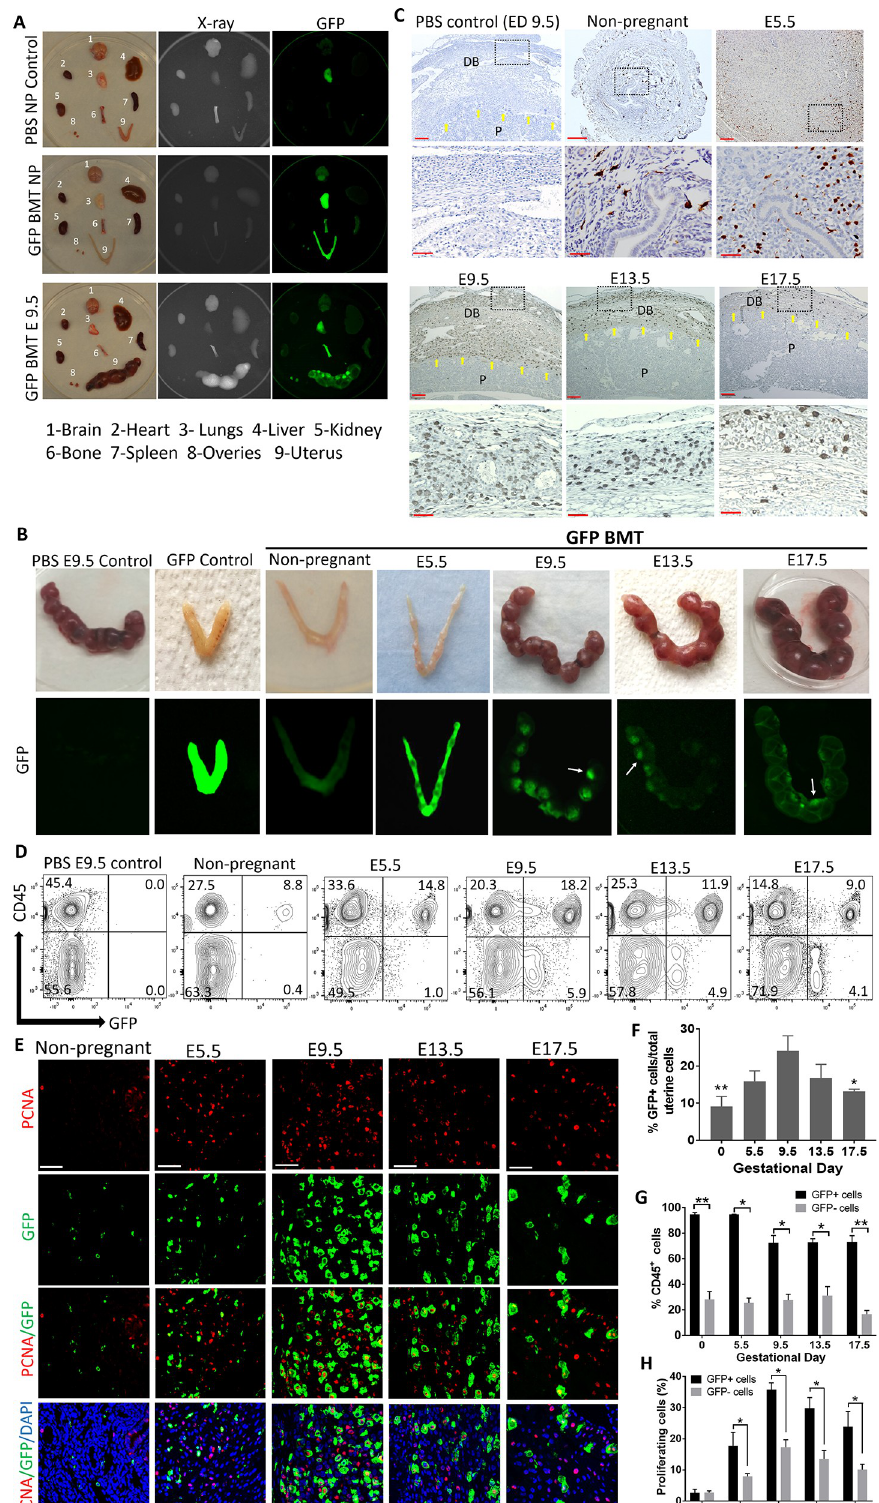
Fig 1. Spatial and temporal contribution of BMDCs to decidua throughout mouse pregnancy. (A) Biodistribution of BM-derived (GFP + ) cells showing preferential recruitment to the pregnant uterus as compared with other body